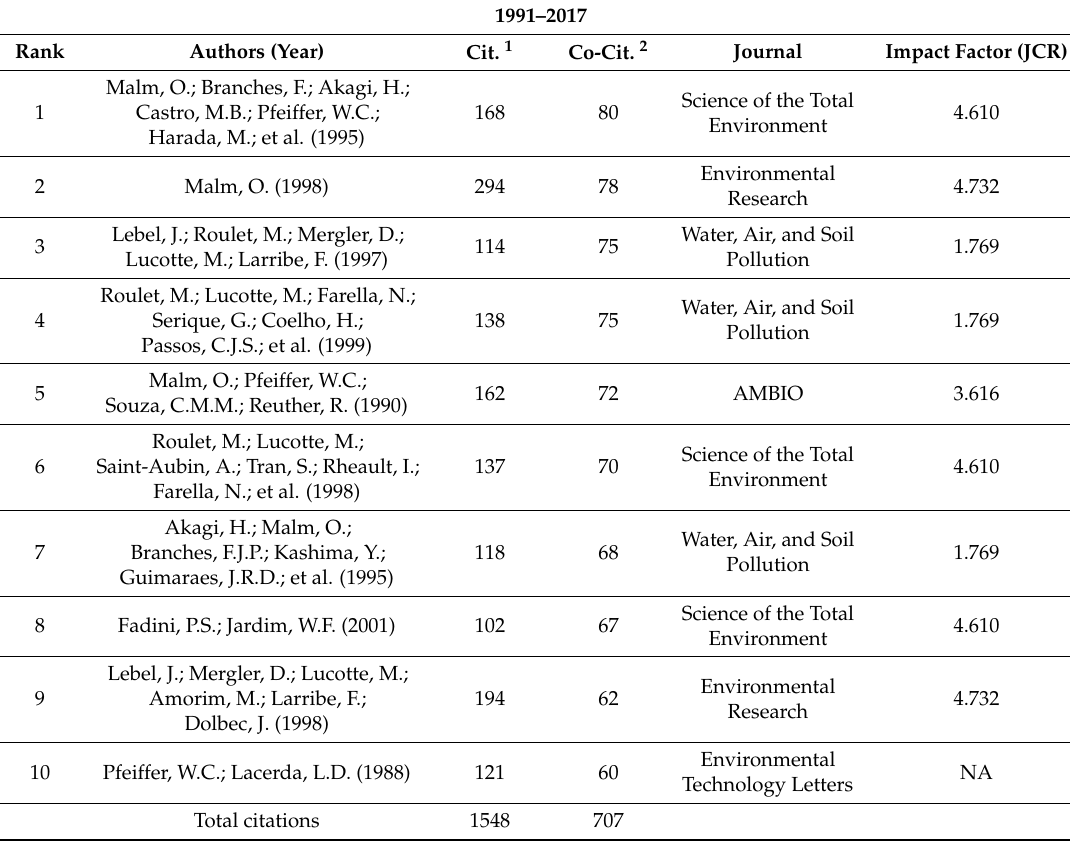
Table 3. Ranking of the top 10 most cited papers within the articles